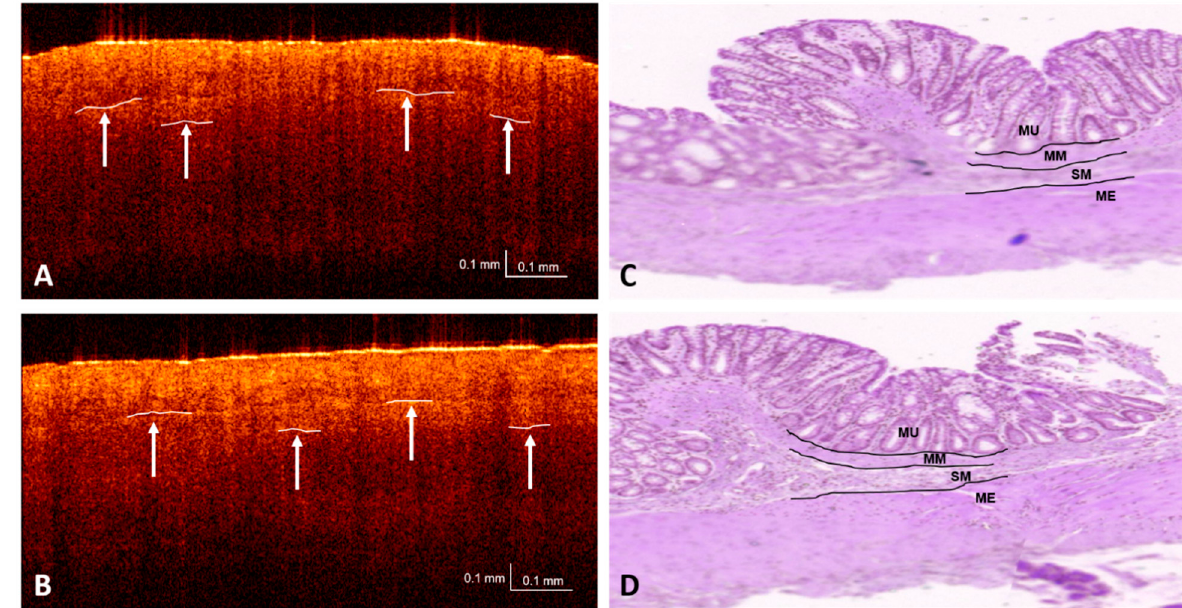
Figure 4. Comparison of features identified in optical coherence tomography (OCT) images ( A , B ) with respect to pathologists’ annotations on H&E images ( C , D ) on healthy sample (Figure 1A). MU: mucosa, MM: muscularis mucosae, SM: submucosa, ME: muscularis externa.